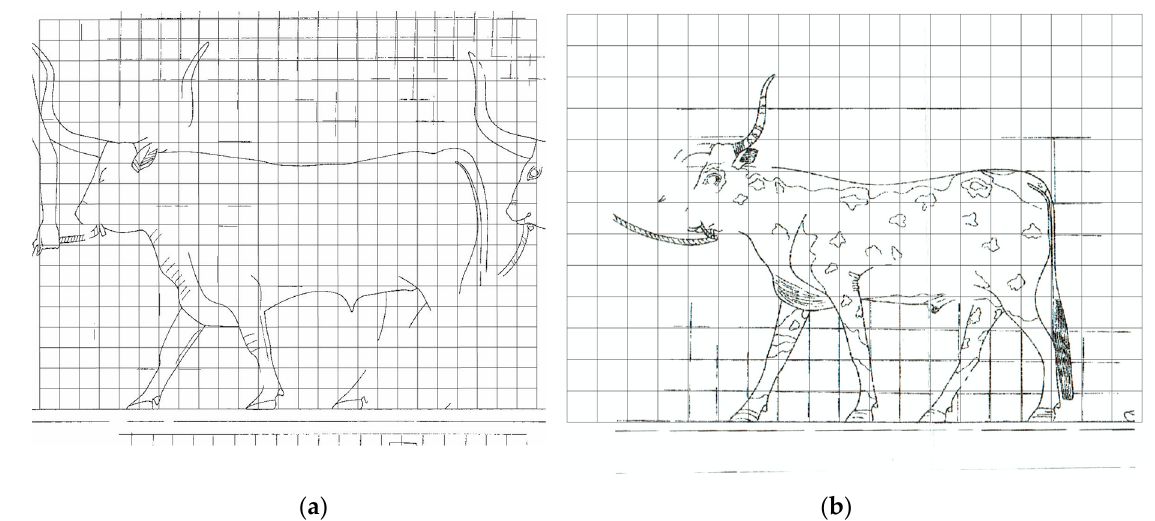
Figure 1. ( a,b ) Oxen from the tomb of Wekh-hotep (Tomb B2) at Meir (left) and the tomb of Amenemhat (Tomb 2) at Beni Hassan with their surviving grid systems reconstructed. These two grid systems will hereby be referred to as the hypo- thetical Meir and Beni Hassan grids. Images: Kanawati and Evans (2017, pl. 90) and Kanawati and Evans (2016, pl. 105), respectively, with the grid systems reconstructed by the author.